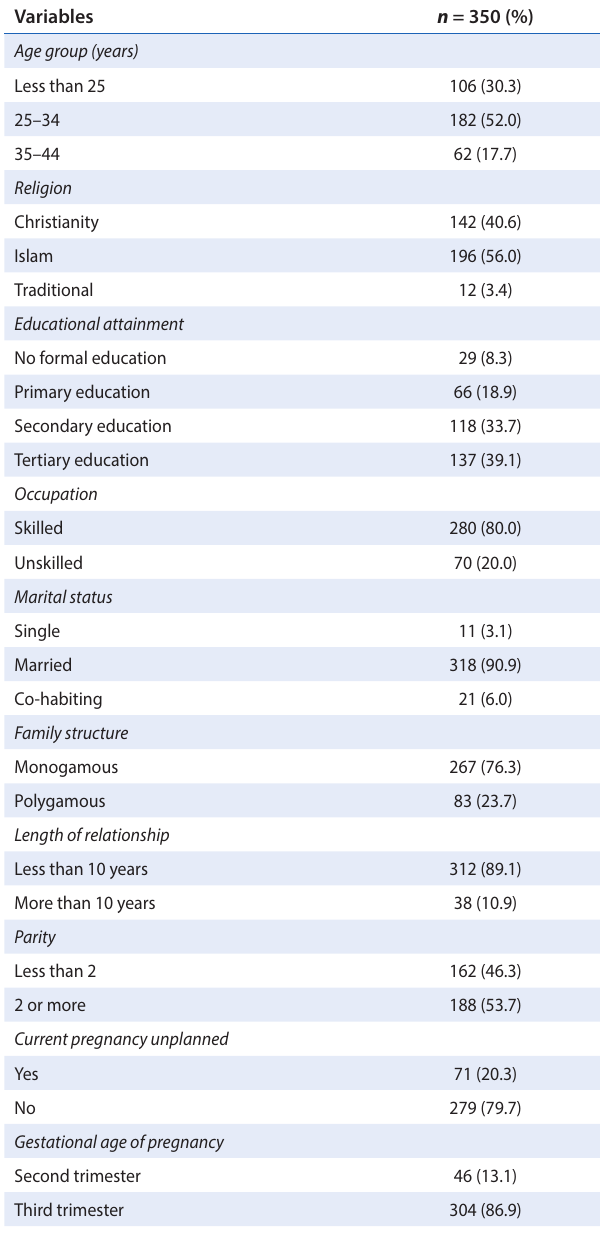
*Multiple entries